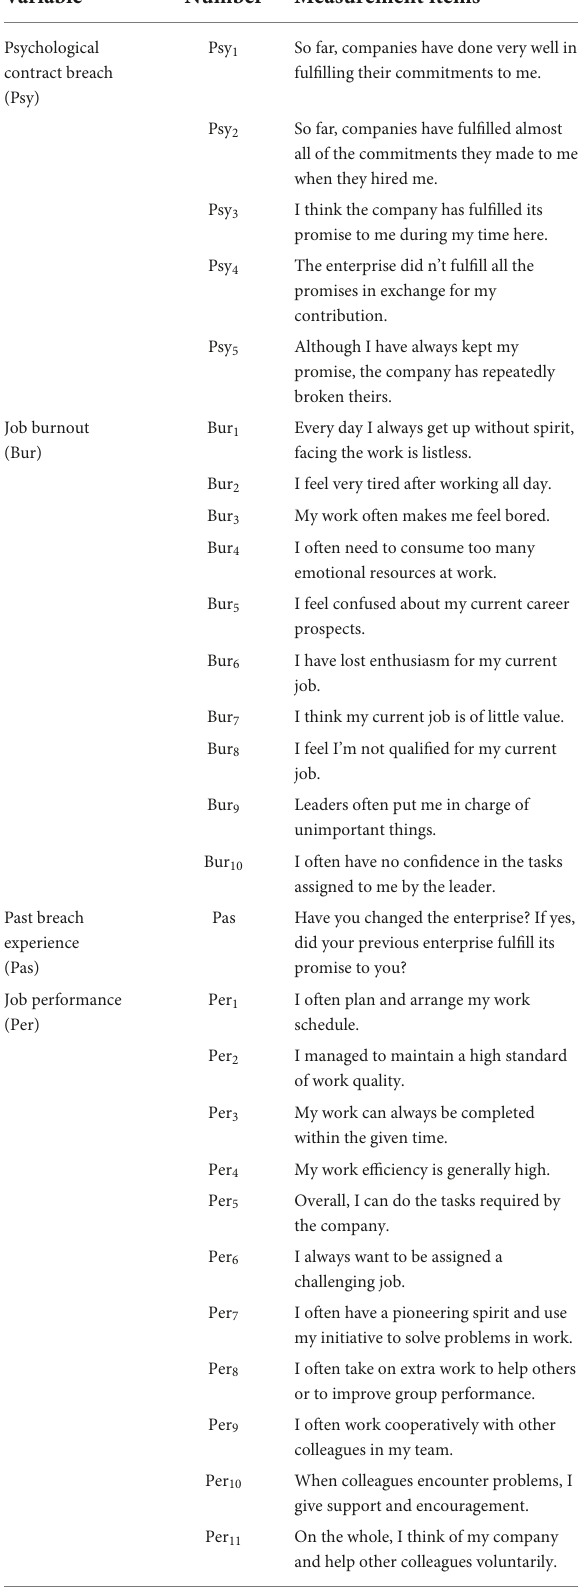
TABLE 1 Description of